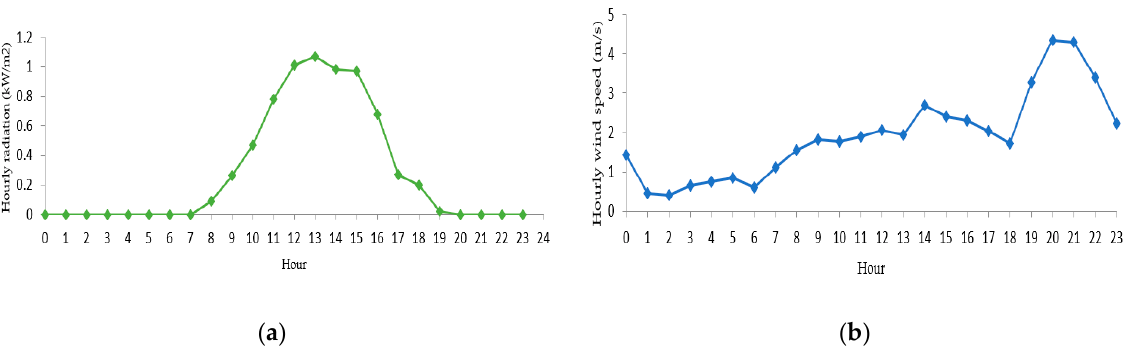
Figure 5. ( a ) Solar radiation variation for a typical day; ( b ) hourly wind speed variation. Table 7. Solar radiation, wind speed, and temperature of the